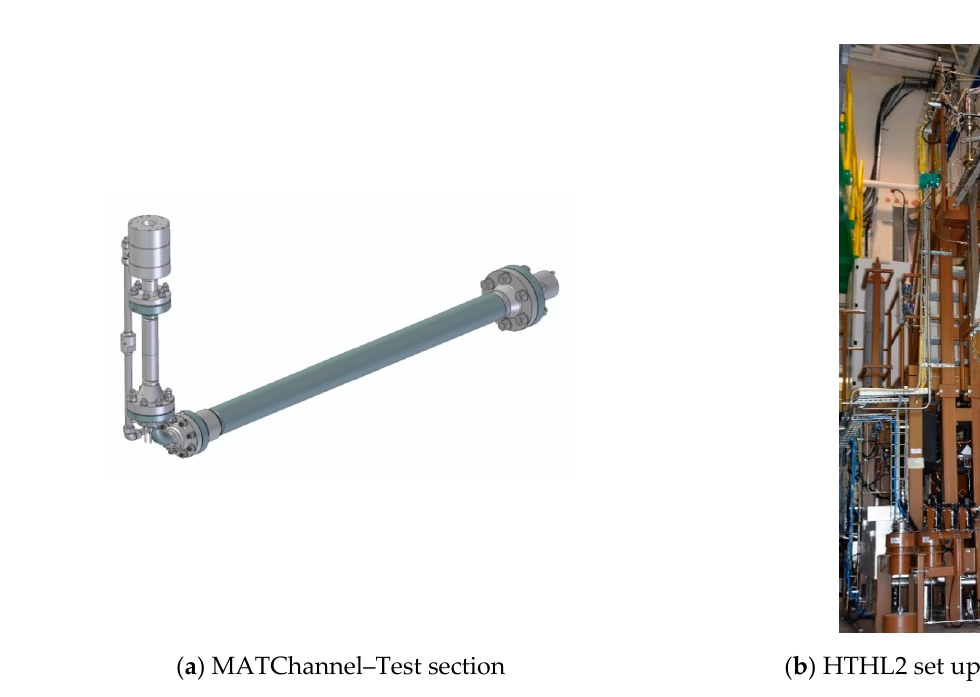
Figure 2. Experimental setup for corrosion/erosion testing in High Temperature helium environment (CVR); ( a ) Test section with samples; ( b ) the experimental loop with the test section